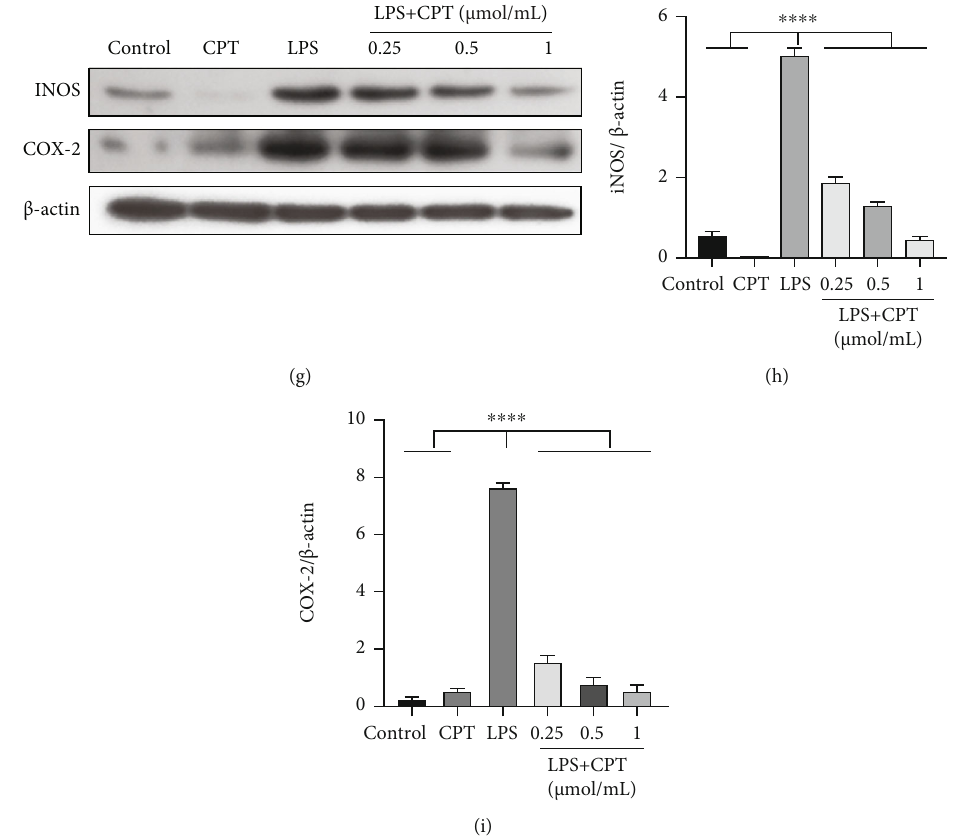
Figure 6: E ff ects of camptothecin (CPT) on LPS-induced in fl ammatory response in RAW264.7 cells. RAW264.7 cells were cultured with di ff erent doses of CPT (0.1, 0.2, 0.4, 0.8, 1.0, 2.0, and 5.0 μ mol/mL) for 4 h, and their viability was determined by CCK8 assay. (a) The e ff ect of CPT was determined by CCK8 assay. RAW264.7 cells were pretreated with di ff erent doses of CPT (0.25, 0.5, and 1 μ mol/mL) for 1h and stimulated with LPS for 4h. Protein and mRNA levels were determined by qRT-PCR and western blot, respectively. The mRNA levels of (b) IL-1 β , (c) IL-6, (d) TNF- α , (e) iNOS, and (f) COX-2 were determined and normalized to the mRNA level of β -actin. The protein levels of (g, i) COX-2 and (g, h) iNOS and the relative protein levels were quanti fi ed by scanning densitometry and normalized to the protein level of β -actin. Values are presented as mean ± SD ( ∗ P < 0 : 05 , ∗∗ P < 0 : 01 , ∗∗∗ P < 0 : 001 , and ∗∗∗∗ P < 0 : 0001 vs. the LPS group).